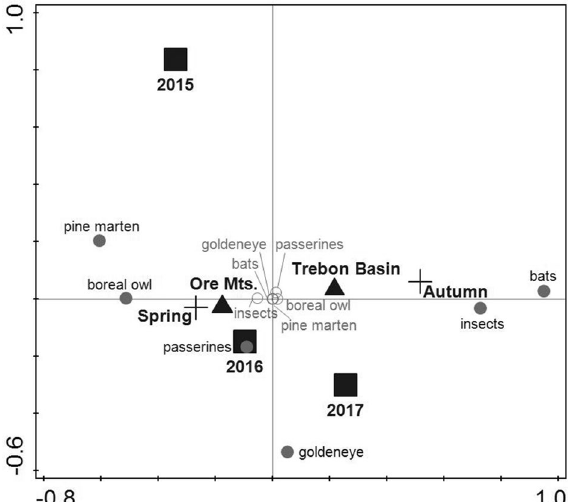
Figure 4. The effect of the study area (Ore Mts. and Trebon Basin, black triangle), year (2015–2017, black square), period (spring and autumn nest box inspections, black cross) on nest box use by different taxa (boreal owl, pine marten, goldeneye, passerines, bats, and insects). The presence (grey circle, black front) and the absence (white circle, grey front) of different taxa are shown. The canonical correspondence analysis (CCA) was used. The first and second ordination axes together explained 98.7% of the